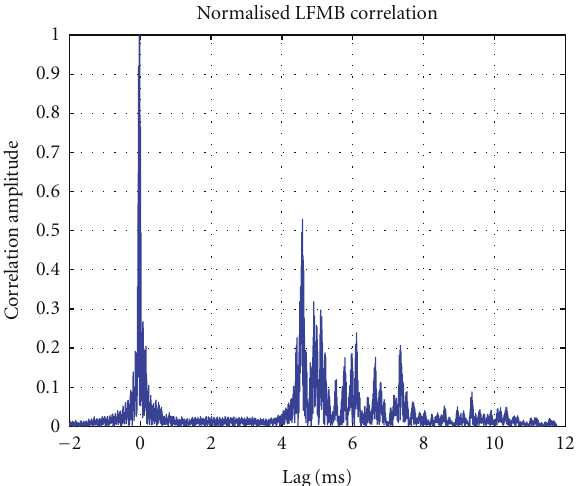
Figure 4: An example of normalized LFM